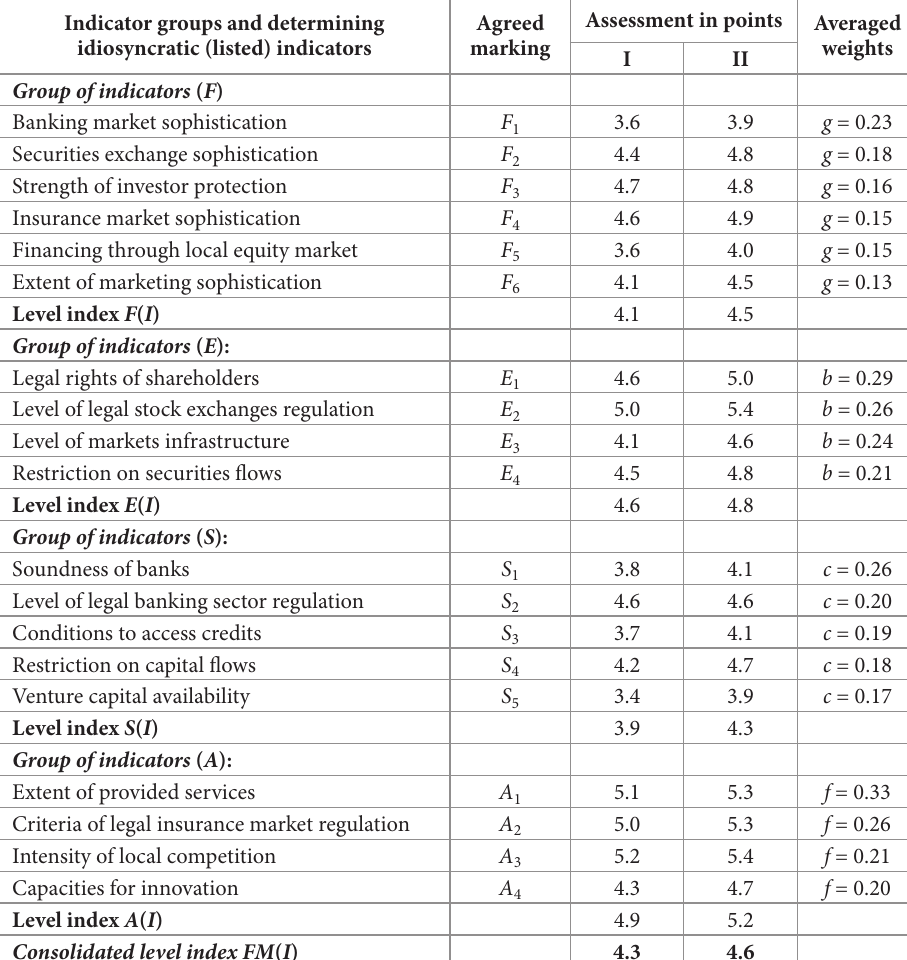
Table 2. The results of assessment of essential (listed) indicators, their weights, and determination of indicator group indexes as well as development index of Lithuanian financial markets Indicator groups and determining idiosyncratic (listed)